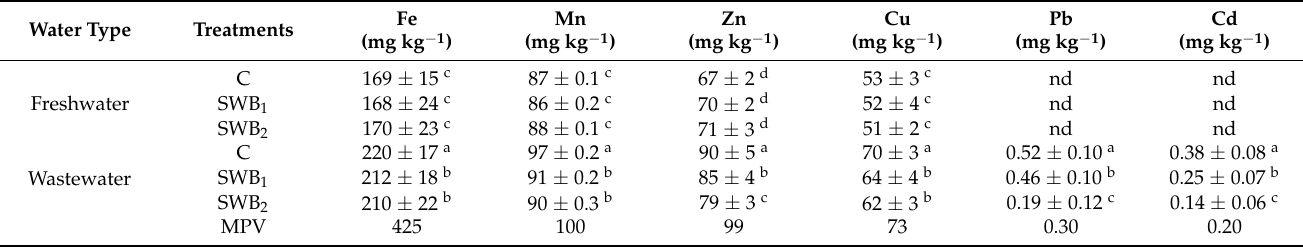
Figure 4. Effect of shrimp-waste-derived biochar (SWB) rates in metal concentrations in quinoa leaves. C, SWB 1 , and SWB 2 are 0, 1, and 2% ( w / w ) of biochar. ( A ) Fe, ( B ) Mn, ( C ) Zn, ( D ) Cu, ( E ) Cd, and ( F ) Pb. Means ( ± SD, n = 5) with different letters indicate significant differences. Cd and Pb were Figure 4. Effect of shrimp ‐ waste ‐ derived biochar (SWB) rates in metal concentrations in quinoa below detection in the case of freshwater. leaves. C, SWB 1 , and SWB 2 are 0, 1, and 2% ( w / w ) of biochar. ( A ) Fe, ( B ) Mn, ( C ) Zn, ( D ) Cu, ( E ) Cd, and ( F ) Pb. Means (±SD, n = 5) with different letters indicate significant differences. Cd and Pb were below detection in the case of freshwater . Table 7. Effect of shrimp-waste-derived biochar (SWB) rates in metal concentrations in quinoa seeds. C, SWB 1 , and SWB 2 are 0, 1, and 2% ( w / w ) of biochar. Means ( ± SD, n = 5) with different letters The leaves of quinoa plants that were irrigated with wastewater significantly con ‐ indicate significant differences. Cd and Pb were below detection in the case of fresh tained higher concentrations of Fe, Mn, Cu, Zn, Cd, and Pb than those irrigated with fresh ‐ water. SWB addition significantly reduced the levels of Fe, Mn, Cu, Zn, Cd, and Pb in